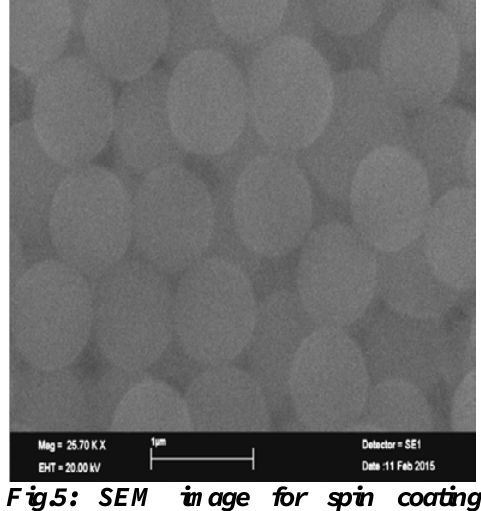
Fig.5: SEM image for spin coating